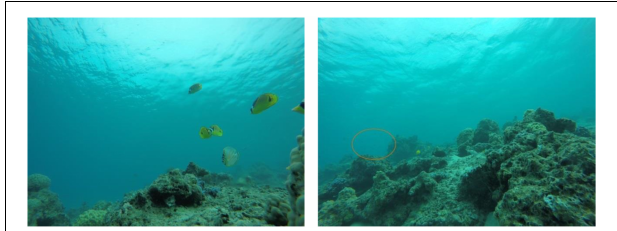
FIGURE 7 | Example of higher fish abundance regarding three-dimensionality and different substrate manifestation in the depth of the images [left: spring site with less substrate, right: control site with more pronounced substrate and a higher number of fish in the depth of the image (orange circle)].